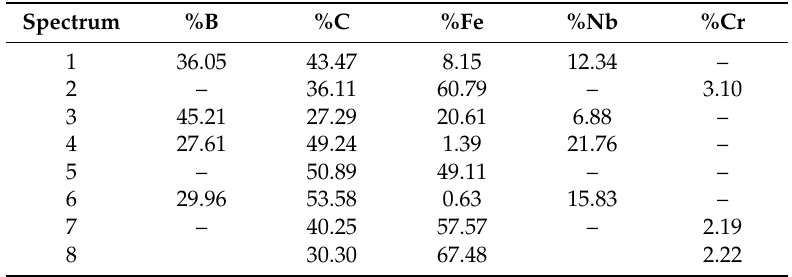
Table 7. Results of the microanalysis performed by SEM-EDX, corresponding to Figure 2a,b. Atomic (%).